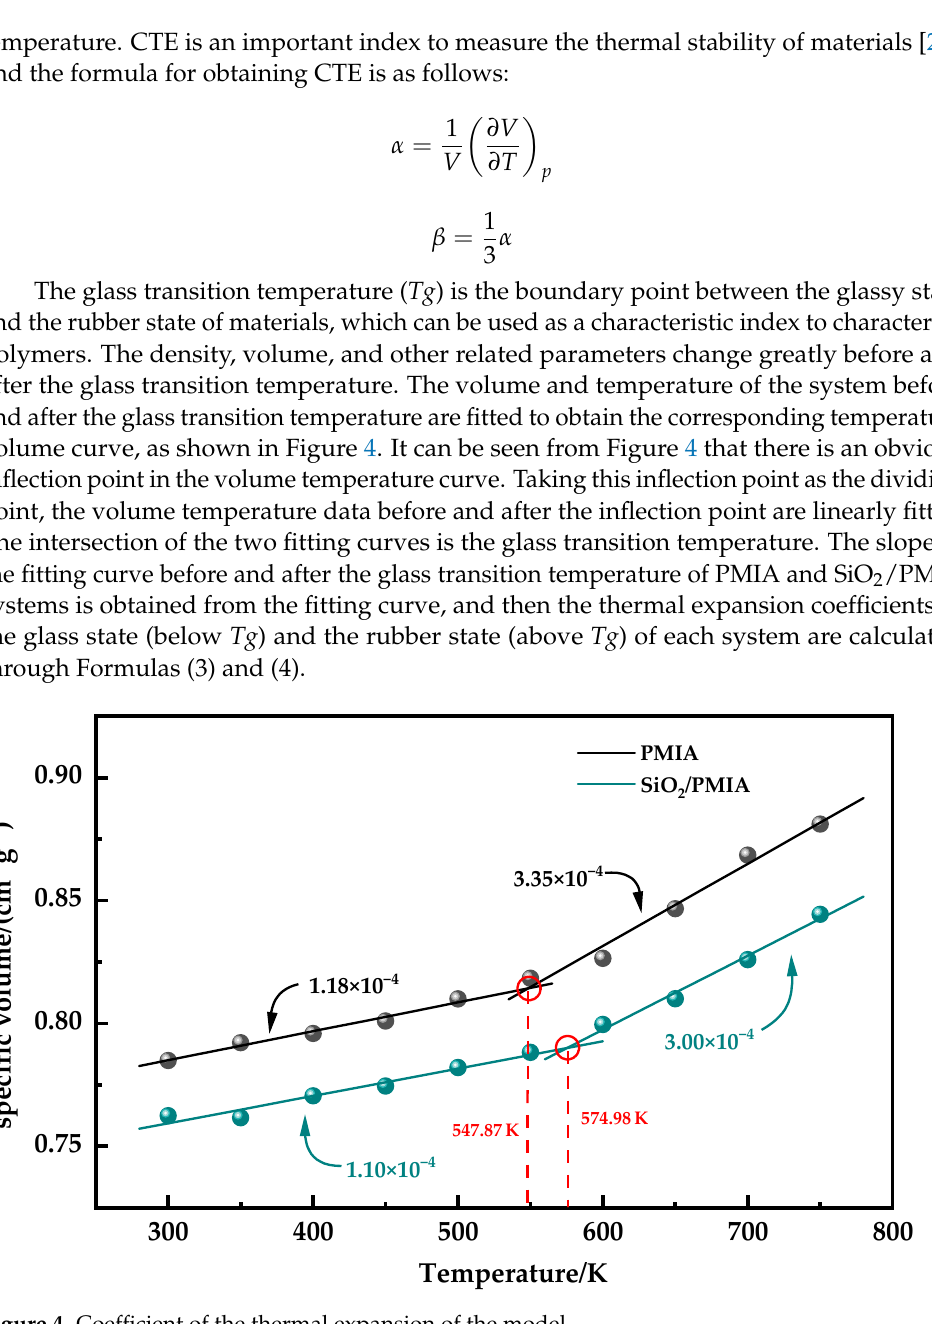
Figure 4. C oefficient of the thermal expansion of the model. Figure 4. Coefficient of the thermal expansion of the